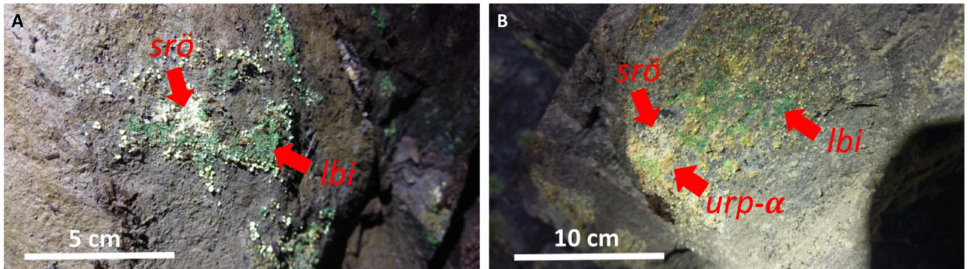
Figure 16. Uranyl mineral assemblage from Podg ó rze mine: ( A ) liebigite (lbi) and schröckingerite (shö); ( B ) liebigite (lbi), schröckingerite (shö), and uranyl silicates (urp- α